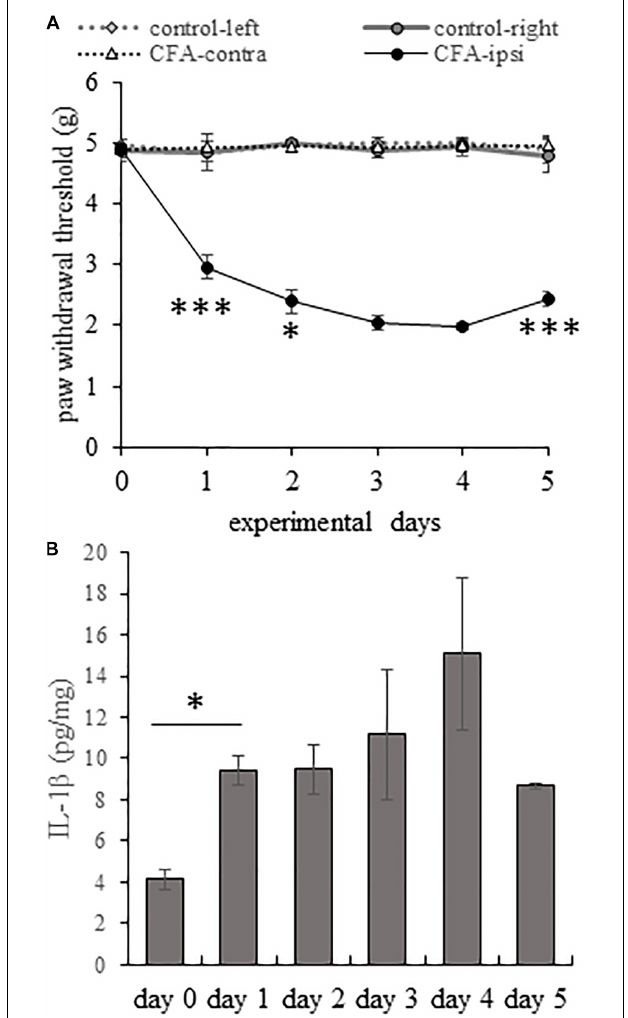
FIGURE 1 | During the course of CFA-induced inflammatory pain IL-1 β production correlates with enhanced mechanical pain sensitivity. (A) Line chart shows the mean mechanical withdrawal threshold (MWT) values on both hind limbs of control animals and animals receiving CFA injection into the right (ipsilateral) hind paw. Note that MWT values appeared to be remarkably stable throughout the entire length of the experimental period in control animals and in the untreated left (contralateral) hind paw of animals receiving CFA injection. However, CFA injection resulted in a significant drop in MWT values in the ipsilateral hind paw of animals on experimental days 1–4. Mechanical pain sensitivity peaked on post-injection day 3 and 4. Data are presented as mean ± SEM. (One way ANOVA, ∗∗∗ p < 0.001; ∗ p < 0.05, asterisk show results of comparison of two consecutive days). (B) Bar chart shows quantitative ELISA measurement of IL-1 β levels in tissue extracts obtained from the L4–L5 lumbar segments of the spinal dorsal horn of the control (day 0) and CFA-injected animals at post-injection days 1–5. Data are shown as mean ± SEM. Note that the cytokine level reached significant elevation on post-injection days 1–5 (One way ANOVA, ∗ p <